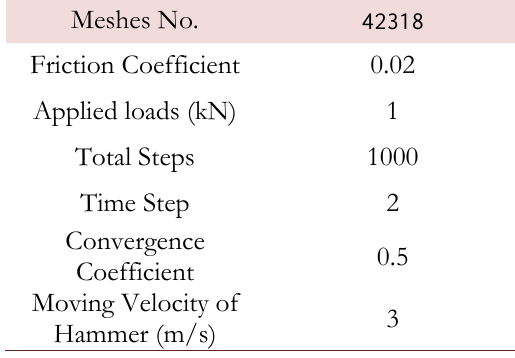
Table 2: Details of boundary condition and solver settings.